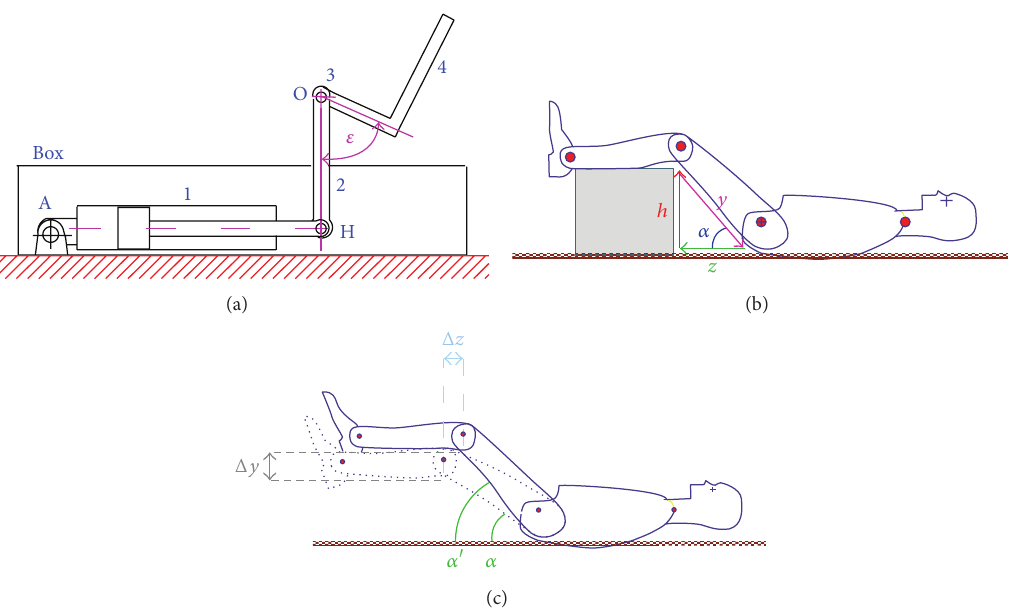
Figure2:(a)Schematicviewofthemechanismunderlyingthesecondprototype.(b)ApproachusedtodetermineBra.Di.P.O.verticalposition regulation. (c) Horizontal movement of the patient’s lower limbs as Bra.Di.P.O. is raised.